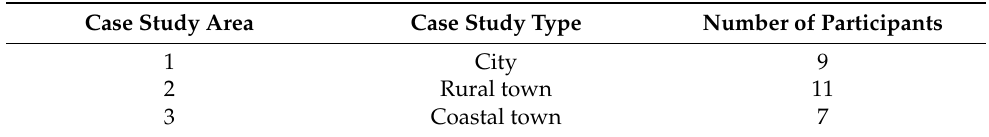
Table 1. Case study areas and number of